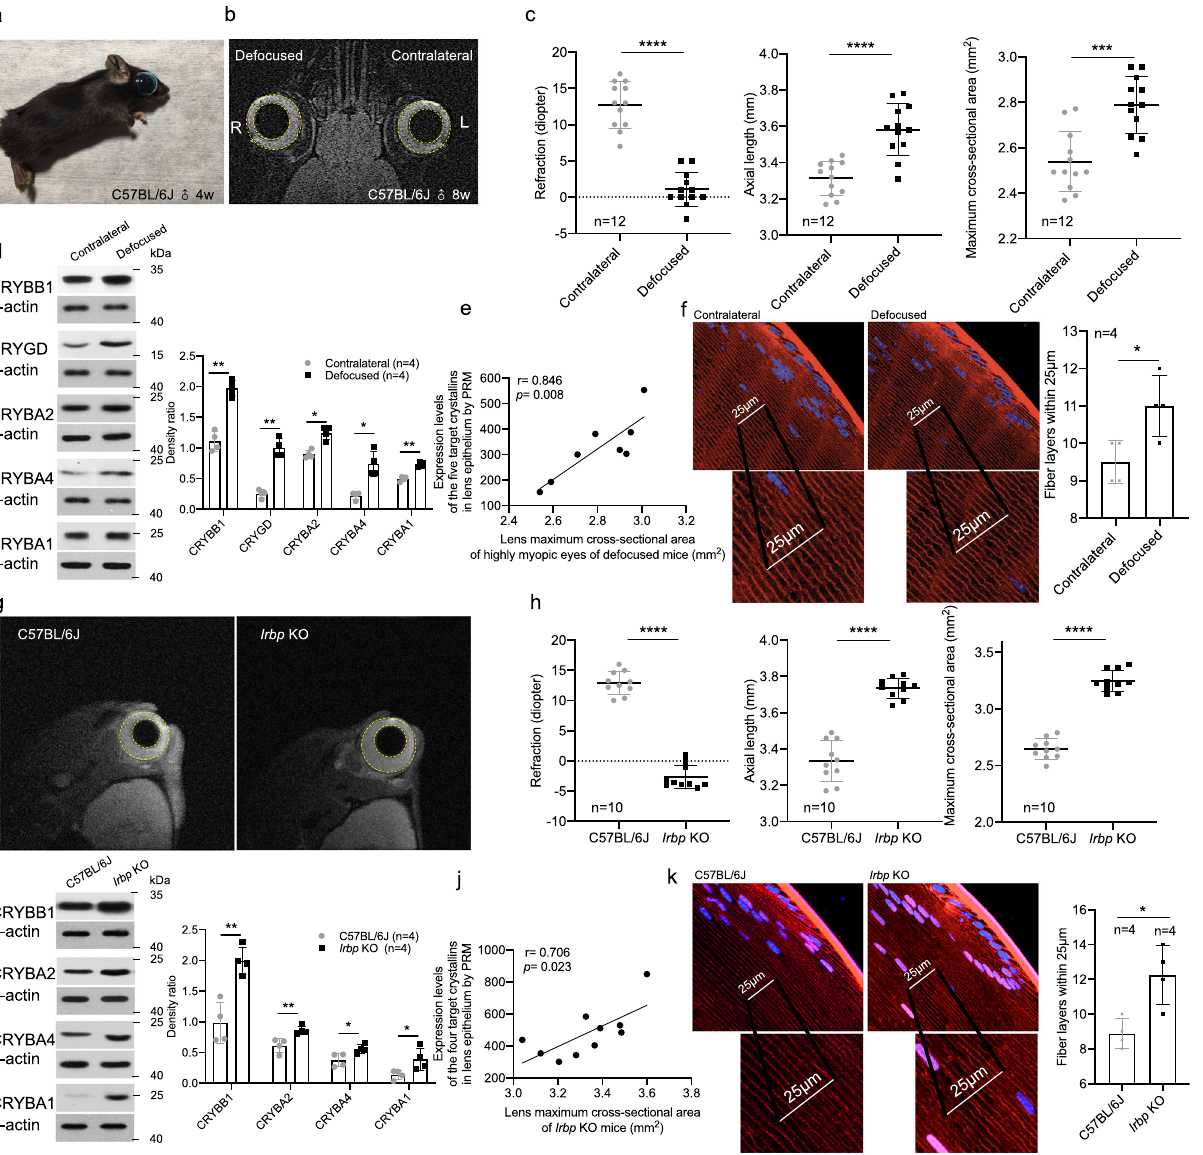
Fig. 3 Increased lens size and β / γ -crystallin expression in two mouse models of high myopia. a A representative photo of a mouse wearing − 25 D lens to induce high myopia in the right eye. b Representative MRI image (coronal image) of an 8-week old mouse with defocus-induced high myopia in the right eye. Dotted yellow lines indicate the contour of the eyeball and the lens. c The refraction, axial length and maximum cross-sectional area of mouse lens ( n = 12, p = 1.36e − 7, p = 3.23e − 5, and p = 0.0006, respectively). d Western blotting of protein expression of crystallin genes in lens epithelium of defocus-induced highly myopic eyes ( n = 4, CRYBB1 p = 0.005, CRYGD p = 0.002, CRYBA2 p = 0.030, CRYBA4 p = 0.028, CRYBA1 p = 0.009). Right, the band density was normalized to loading control as a ratio for statistical analysis. e Correlation between the increased protein levels of fi ve target crystallins in lens epithelium and the maximum cross-sectional area of lens from highly myopic eyes of defocused mice (examined by PRM). f Wheat germ agglutinin (WGA) staining of lens fi ber layers located within a length of 25 μ m approximately 50 μ m beneath the lens surface at the equator ( n = 4, p = 0.014). g Representative MRI images (sagittal images) of 8-week wild type mice and 8-week interphotoreceptor retinoid-binding protein ( Irbp ) knockout (KO) mice. Dotted yellow lines indicate the contour of the eyeball and the lens. h The refraction, axial length and maximum cross-sectional area of mouse lens ( n = 10, p = 5.64e − 13, p = 7.73e − 9, and p = 1.86e − 11). i Western blotting of protein expression of crystallin genes in lens epithelium of Irbp KO mice and C57BL/6J mice ( n = 4, CRYBB1 p = 0.003, CRYBA2 p = 0.008, CRYBA4 p = 0.030, CRYBA1 p = 0.044). Right, the band density was normalized to loading control as a ratio for statistical analysis. j Correlation between the increased protein levels of four target crystallins in lens epithelium and the maximum cross-sectional area of lens from Irbp KO mice (examined by PRM). k WGA staining of secondary lens fi ber layers located within a length of 25 μ m approximately 50 μ m beneath the lens surface at the equator ( n = 4 in each group, p = 0.012). n = biological replicates. In ( d , e , i , and j ), pooled samples were used, of which in ( e and j ), lens epithelial samples were pooled in order of maximum cross-sectional area ( fi ve pieces of lens epithelial samples pooled as one and totally 40 defocus-induced highly myopic mice and 50 Irbp KO mice used here) and the average lens maximum cross-sectional area of each fi ve pooled samples were used in the scatterplot. Results are expressed as mean ± SD. Level of signi fi cance was detected using two-sided paired t test ( c , d , and f ), and two-sided Student ’ s t test ( h , i , and k ). Association between variables was evaluated by Pearson correlation analysis ( e and j , two-sided test was used). **** p < 0.0001, *** p < 0.001, ** p < 0.01, and * p < 0.05. Source data are provided as a Source Data fi le.